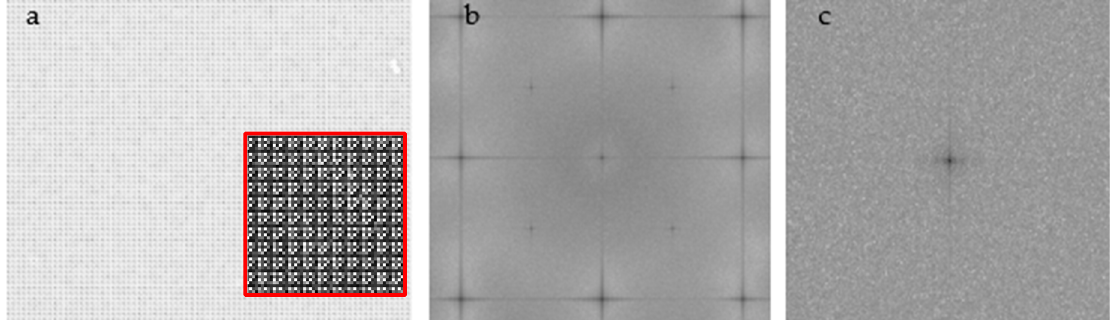
Figure 5 . Centroided image with 11 μ m effective pixel size for open beam radiograph. The 800% zoomed-in section to show centroiding pattern effect is in the bottom right corner ( a ). Fast Fourier transform of the centroided open beam area to demonstrate the detector characteristics which reveals some artefacts from centroiding ( b ). Fast Fourier transform of non-centroided open beam demonstrating there are no unusual artefacts in the raw data ( c ).